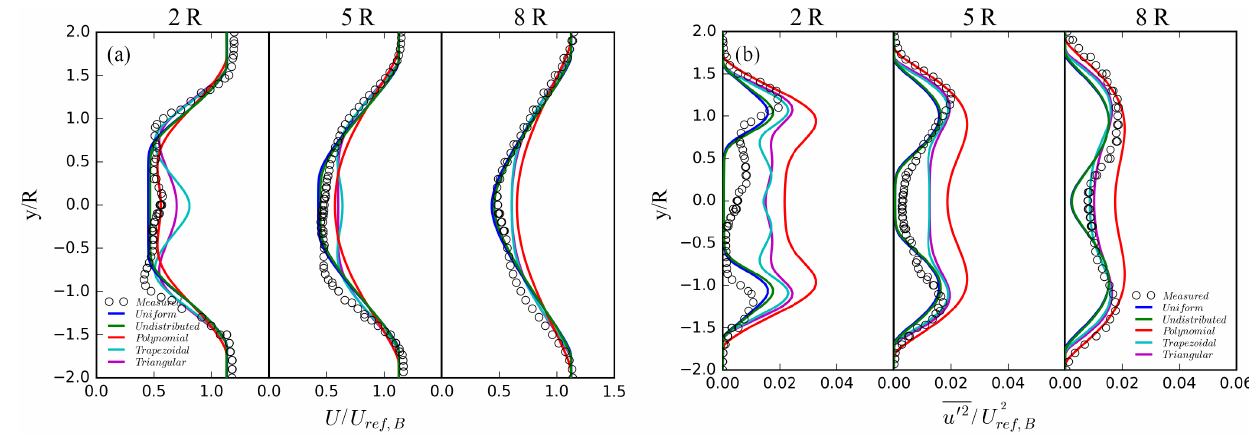
Figure 9. (a) Normalized axial velocity and (b) normalized stream-wise variance of the velocity computed for the two in-line model wind turbines (case B) at x/R = 2, 5 and 8 downstream of the second wind turbine for different thrust distributions and the k - ε turbulence model.